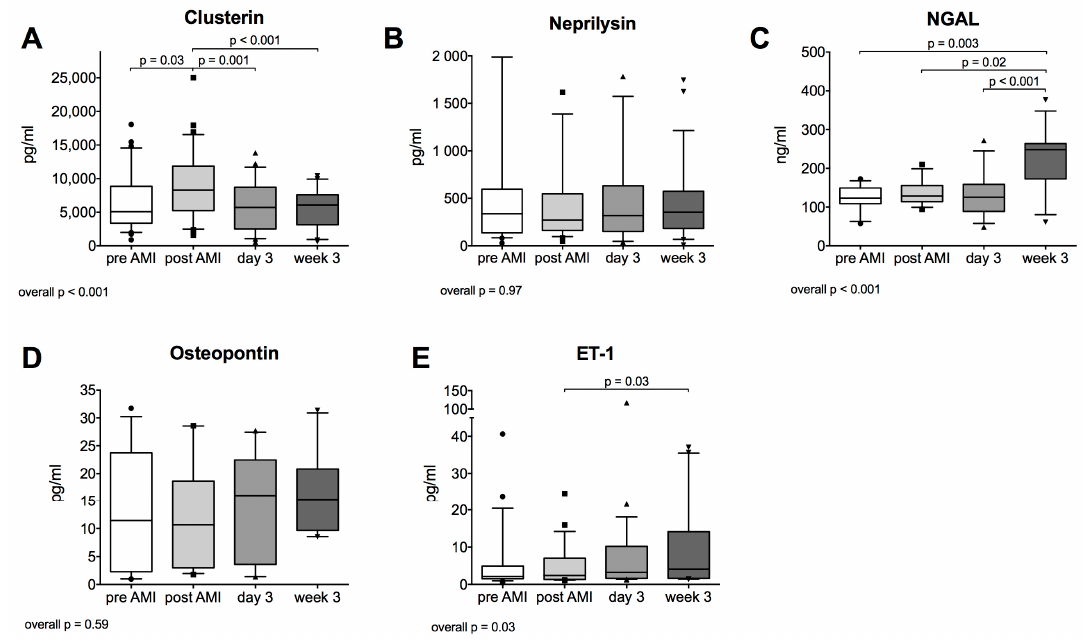
Figure 2. Plasma Clusterin ( A ), Neprilysin ( B ), neutrophil gelatinase-associated lipocalin (NGAL) ( C ), Osteopontin ( D ) and endothelin-1 (ET-1) ( E ) before acute myocardial infarction (AMI), after AMI, on day 3 and week 3 after AMI ( n = 24).